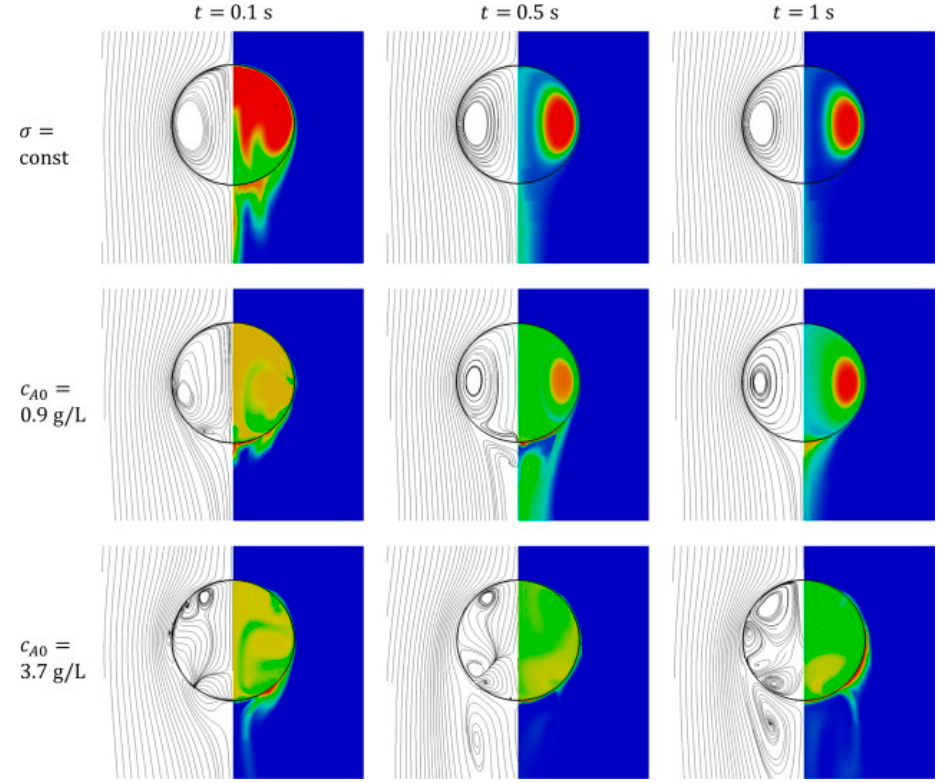
Figure 7. Streamlines and concentration fields of simulations without ( top ) and with Marangoni convection (c A0 = 0.9 g/L ( middle ), c A0 = 3.7 g/L ( bottom ), and c A0 was the initial concentration of acetone in the droplet) after a rise time of 0.1 s, 0.5 s, and 1 s (( left ) to ( right )). Reprinted with permission from Ref. [113]. 2014, Elsevier.